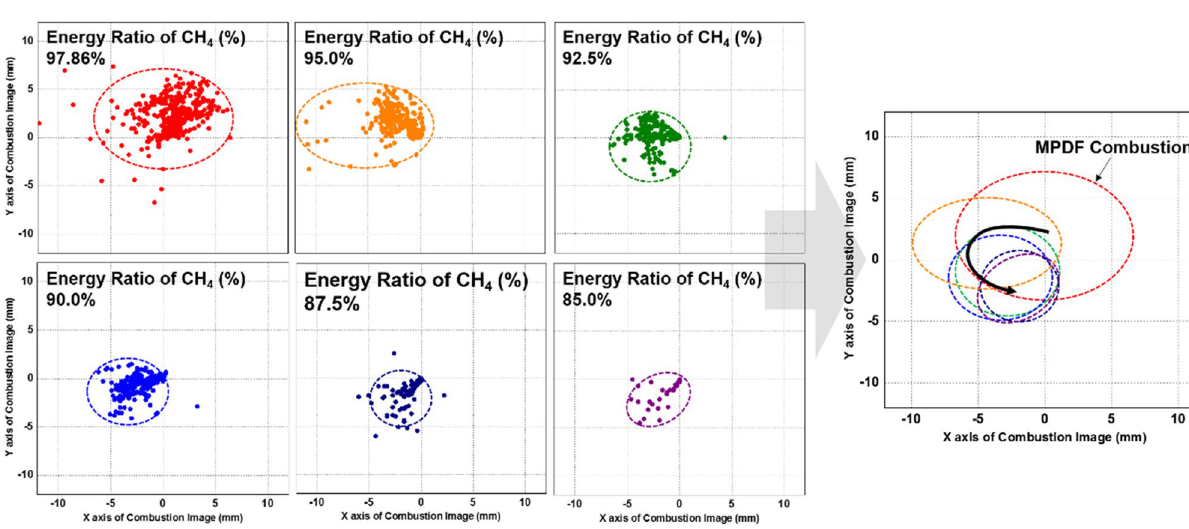
Figure 19. Variation of central coordinates of the flame surfaces with respect to the fuel mixture ratio.